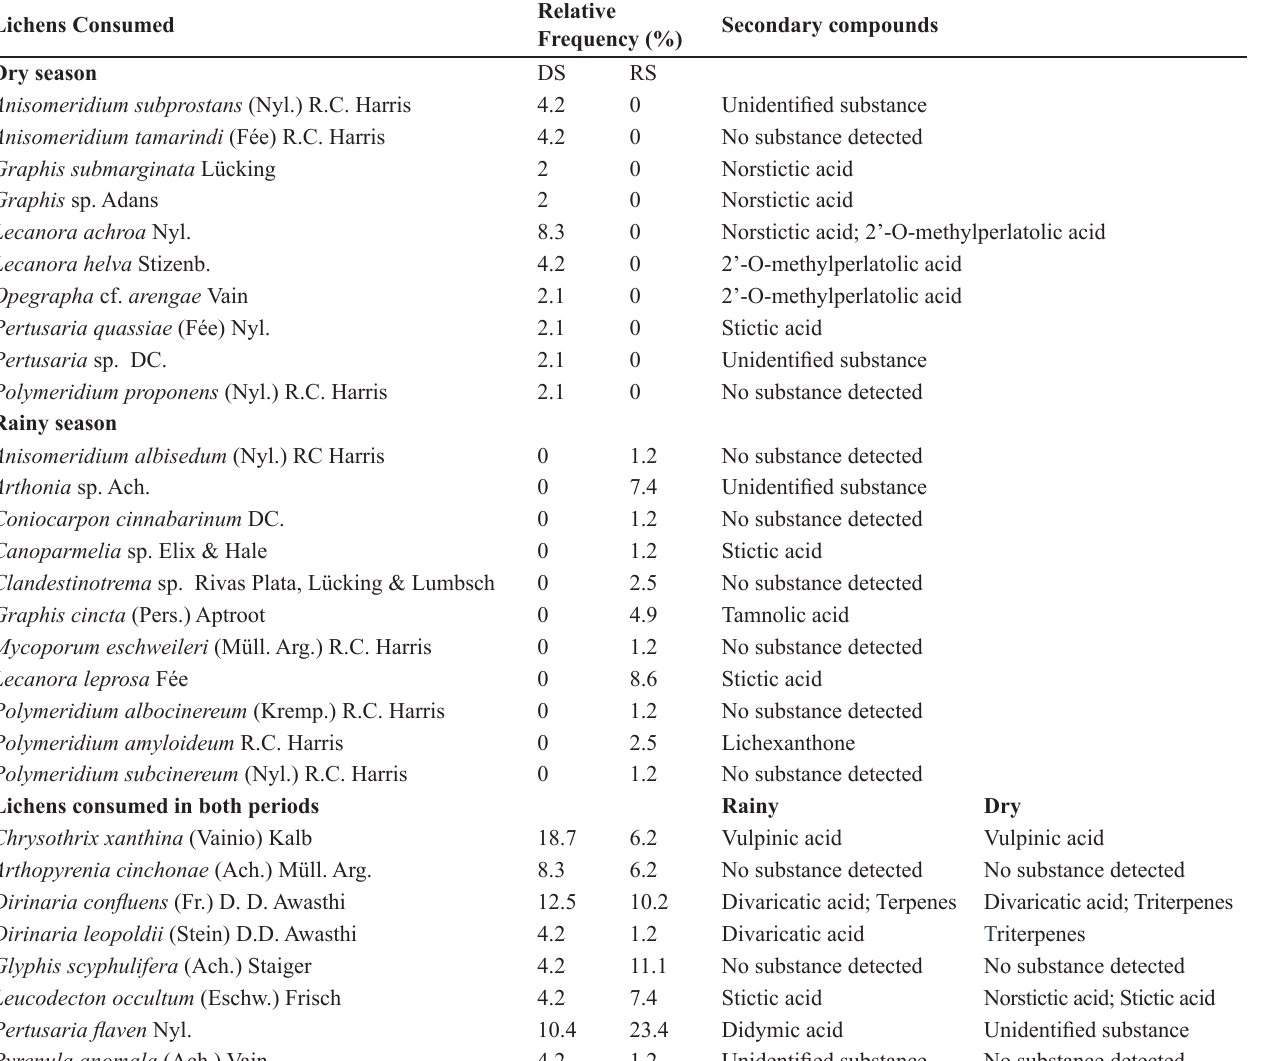
Table 1. Lichens consumed by Constrictotermes cyphergaster , relative frequency (%) of visits to the lichen thalli and secondary compounds